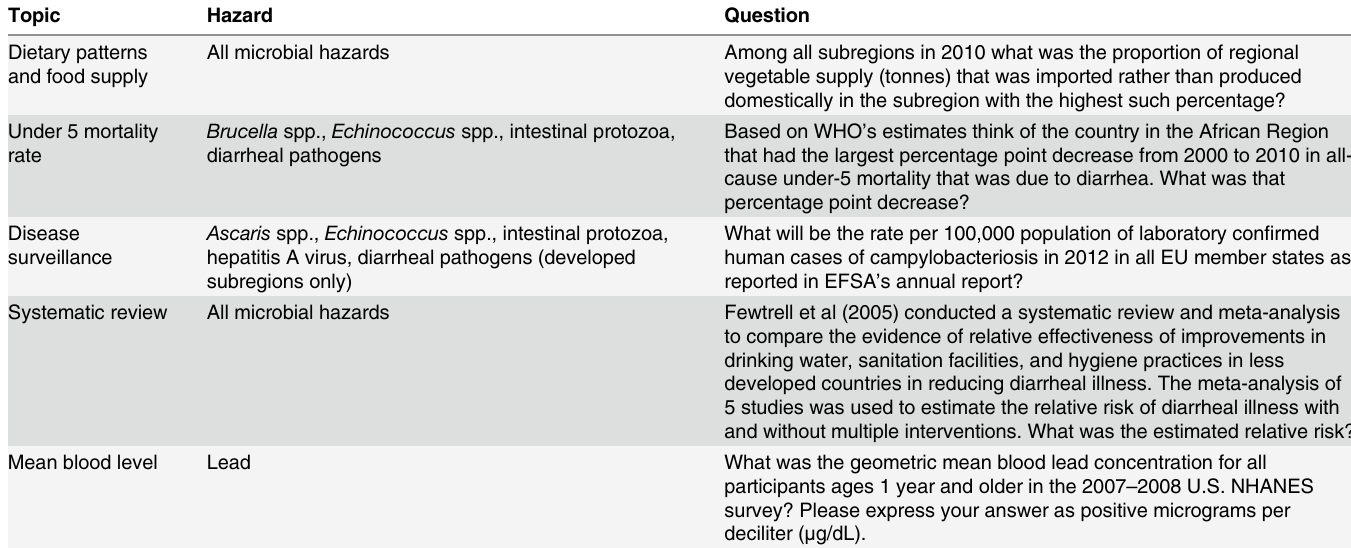
Table 2. Examples of calibration seed